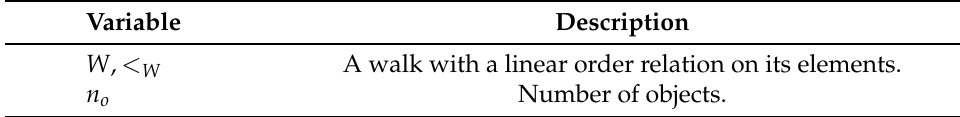
Table 12. Input data for the Phase 1 algorithm.